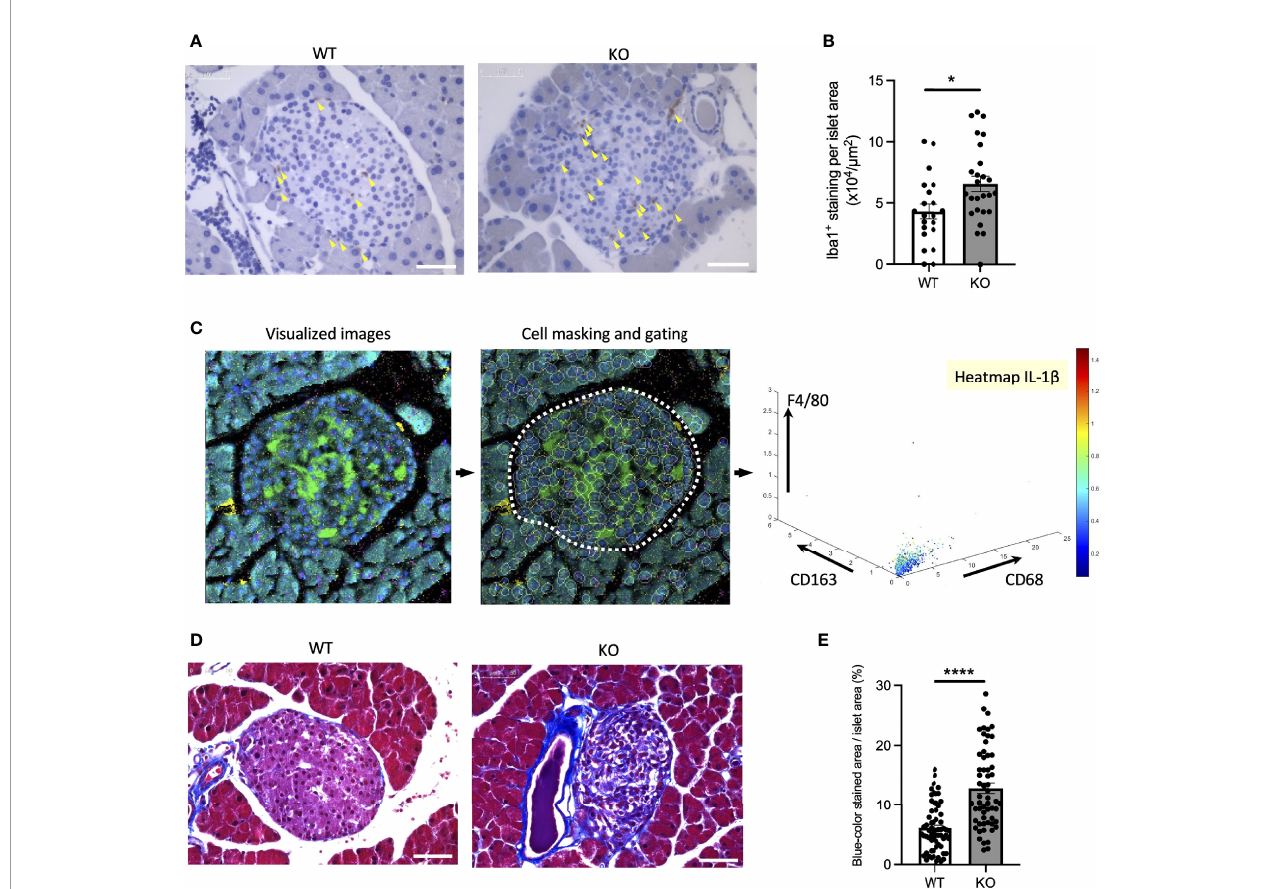
FIGURE 5 | Macrophage in fi ltration and fi brosis in the Wolfram syndrome mouse model islets. (A) Iba1 DAB staining of the islets from Wfs1 wild-type (WT) and whole-body knockout 129S6 (KO) male mice at 10 months of age. Yellow arrowheads point to the stained macrophages. Scale bars 50 µm. (B) The number of Iba1 positive cells was normalized to each islet ’ s area size (WT, n=21; KO, n=28). (C) Left panel: Visualized imaging mass cytometry (IMC) image of KO male mouse stained with F4/80 (red), insulin (green), DNA (blue), CD68 (magenta), and CD163 (yellow). Contrast staining was performed with Ruthenium (cyan). Middle panel: cells were masked, and the islet area was gated. Right panel: Scatter plot of F4/80, CD163, and CD68. IL-1 b was shown in the heatmap. (D) Trichrome-Masson staining of the islets from WT and KO male mice at 10 months of age. Collagen fi bers are stained in blue. Scale bars 50 µm. (E) The blue-colored area was normalized to each islet ’ s area size (WT, n=33; KO, n=34). Data are shown in mean ± SEM, *P < 0.05, ****P <